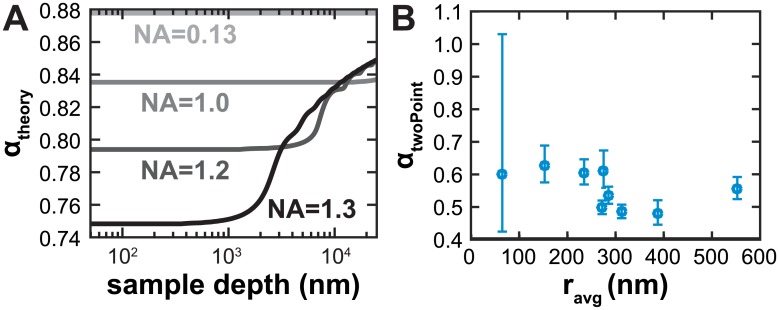
Constant α near the the coverslip.(A) Apparent α for various sample depths as predicted by Eqs 1–2. (B) α
twoPoint plotted against the average radius of the two bead sizes that went into the measurement.